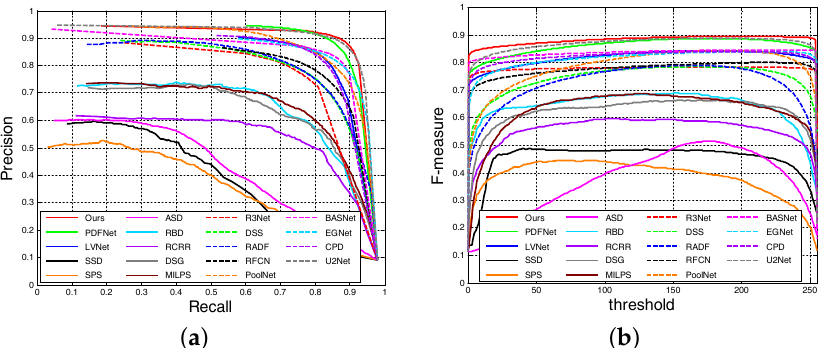
Figure 2. (Better viewed in color) quantitative evaluation of different saliency models: ( a ) P-R curves of different methods of the ORSSD dataset, and ( b ) F-measure curves of different methods of the ORSSD dataset.